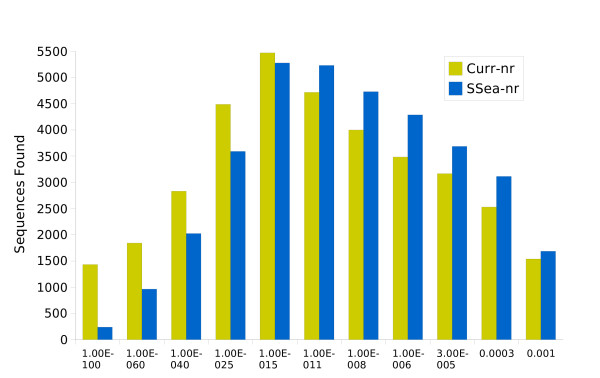
Distribution of BLAST e-values. Here the sequences all come from BLAST searches of the Combined-nr database. Here BLAST runs with the 237 target sequences finds as many related Sargasso Sea sequences as sequences from the current database. The distribution of the sequences is a difference between the two sequence resources though, sequences from the Sargasso Sea databases are found with higher E-values on the whole, something that is probably a side effect of the high proportion of fragments in the resource.